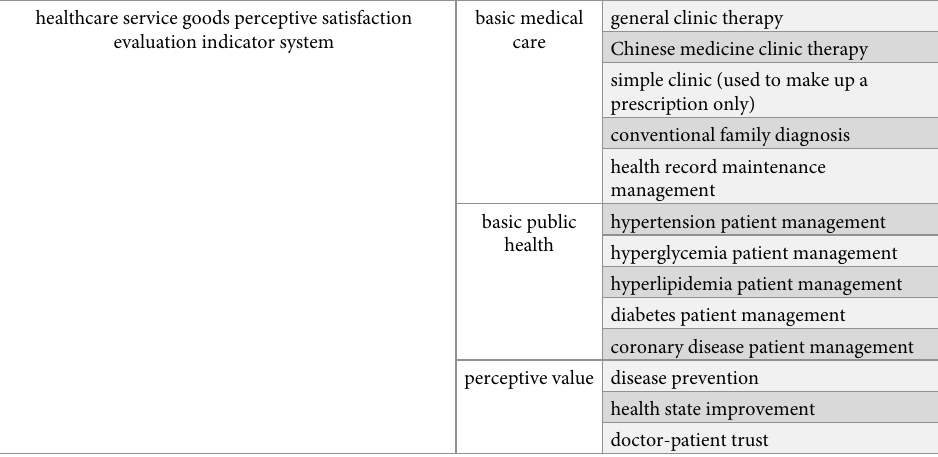
Table 1. Healthcare service goods perceptive satisfaction evaluation indicator